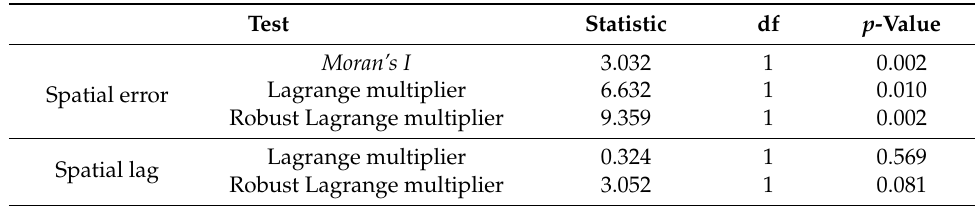
Table 4. Results of Lagrange multiplier